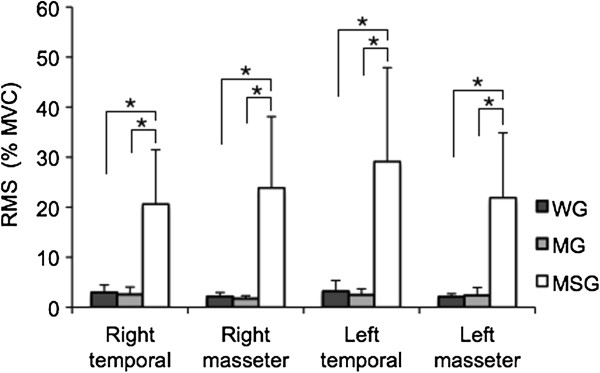
Mean and SD of RMS (%MVC) value recorded in resting position; RMS of right and left masseter and termporal muscles compared between without TMD (WG), with mild TMD (MG) and with moderate to severe TMD (MSG); *Significant difference (
p
< 0.05; Dunn’s post-hoc test).